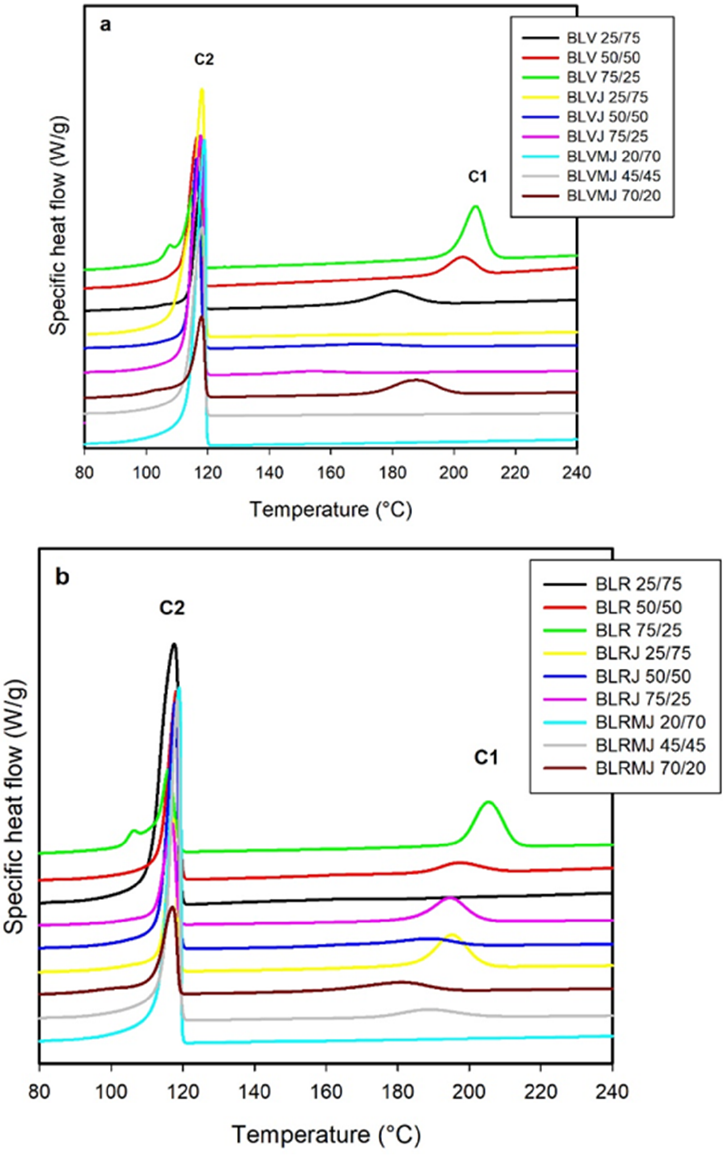
Figure 6. Heat flow as a function of temperature for PETV/HDPE (BLV) ( a ) and PETR/HDPE (BLR) ( b ) blends with 1:3, 3:3, 3:1 ratios, additivated (J) and compatibilized and additivated (MJ), crystallized from the melt with crystallization peaks (C), identified for PET (1) and HDPE (2).